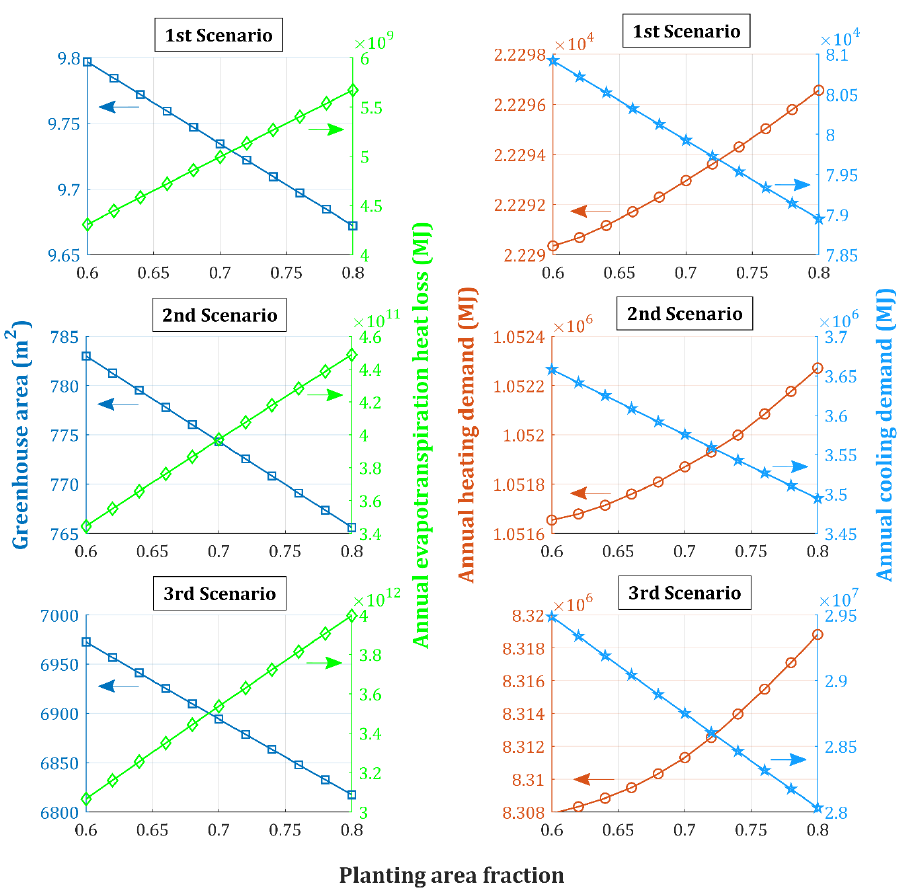
Figure 18. Variations in the greenhouse sizes, annual evapotranspiration heat loss, annual heating demand, and annual cooling demand under the variation in the planting (canopy) area fraction.